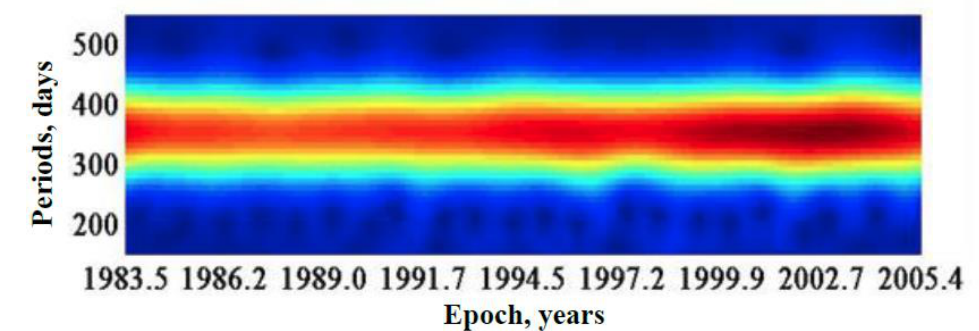
Fig. 1. Continuous time- frequency wavelet analysis (‘morl’ wavelets) of data